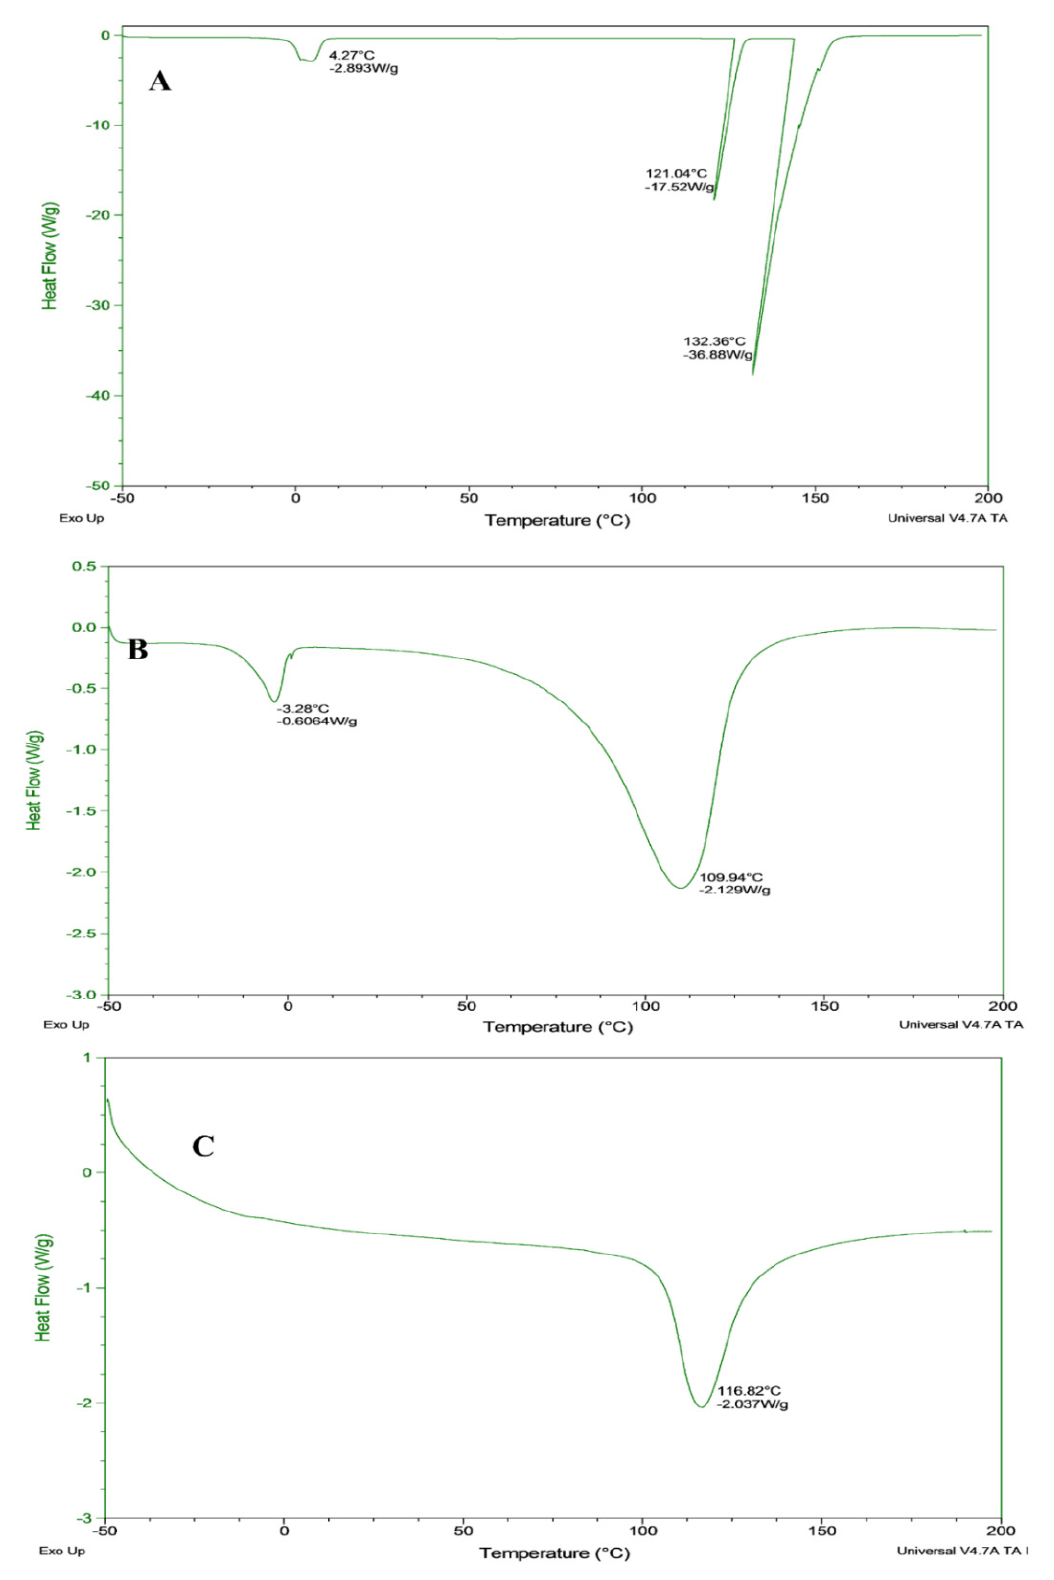
Figure 3. Differential scanning calorimeter of bighead carp H. nobilis fillets. ( A ) Raw; ( B ) oven drying; ( C ) microwave drying.